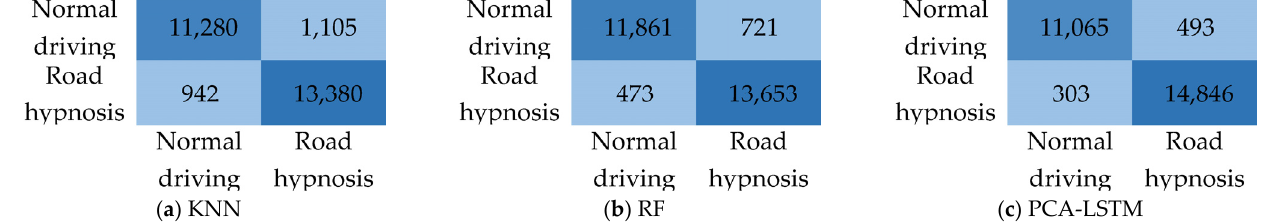
Figure 8. Confusion matrix of simulated driving experiments. Table 9. Validation results of the model.